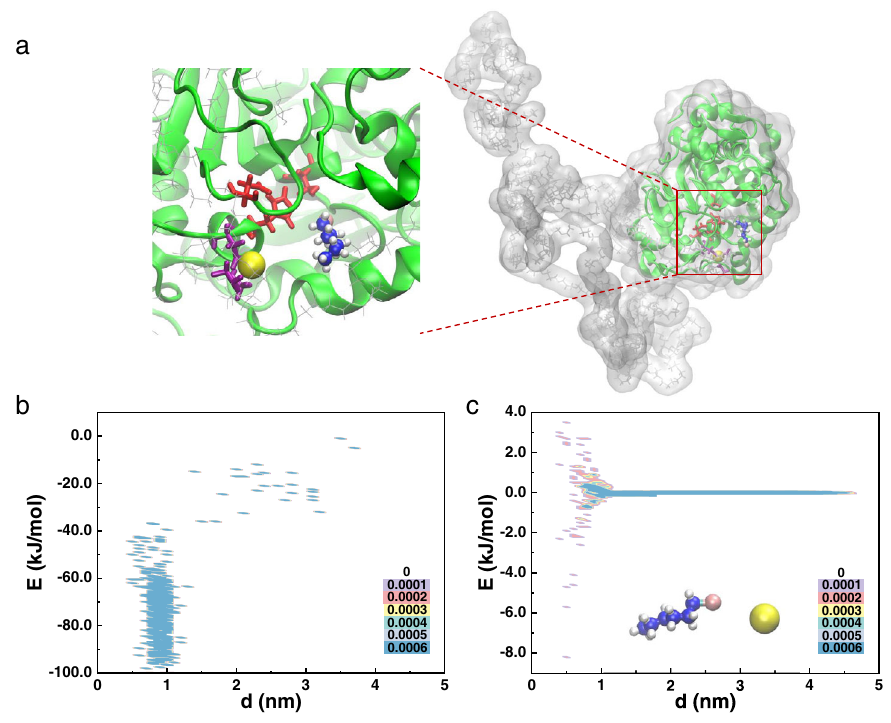
Fig. 4 Molecular dynamics simulations of Pd1/CALB-P binding with 1-bromohexane and forming reaction transition state. a All-atom model of Pd 1 / CALB-P. The enlarged region of the representative snapshots gives the reaction transition state which is stabilized by the active site with a binding energy of 104.5 kJ/mol. Details can be found in supplementary materials. The distribution probability plotted as a function of interaction energy and distance for b , 1-bromohexane to the enzyme active site – adjacent Pd atom and c , 1-bromohexane to the free Pd atom in solution. The distribution probability is shown by the fi lling Supplementary Fig. 12. They are two carboxyl oxygen atoms on the side chain of Asp, two carbonyl oxygen atoms on Asn, hydroxyl and carbonyl oxygen atoms on Ser, two hydroxyl oxygen atoms on two adjacent Ser (named Ser – Ser), hydroxyl and carboxyl oxygen atoms on adjacent Ser and Asp, and two adjacent oxygen atoms on PEO chain, respectively. When the oxygen atom pairs are from different amino acids, in order to ensure the original position of the two amino acids on the protein, we fi xed the C α and adjacent C, N of the amino acid during the optimization of the geometric conformation in DFT calculation. The con fi rmation of enzyme – polymer conjugate in methylbenzene was obtained from our previous work 16 .